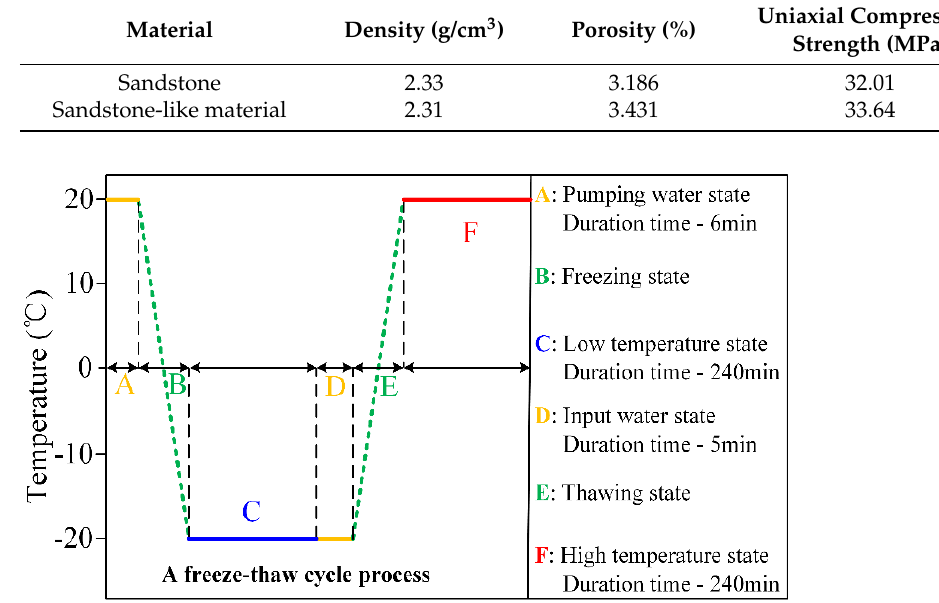
Figure 2. Complete freeze—thaw cycle process.